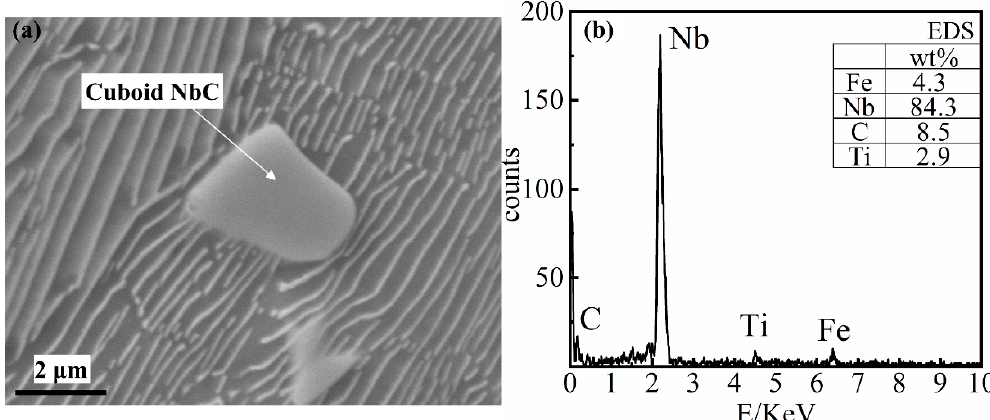
Figure 7. The energy-dispersive X-ray spectroscope (EDS) result of Cuboid NbC precipitate. ( a ) the SEM image of the cuboid NbC; ( b ) the EDS of the cuboid NbC.